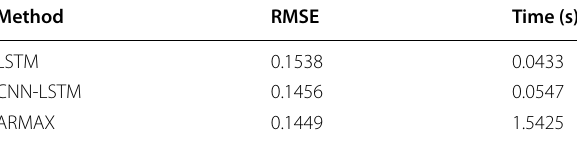
Table 4 Performance comparison for forecasting